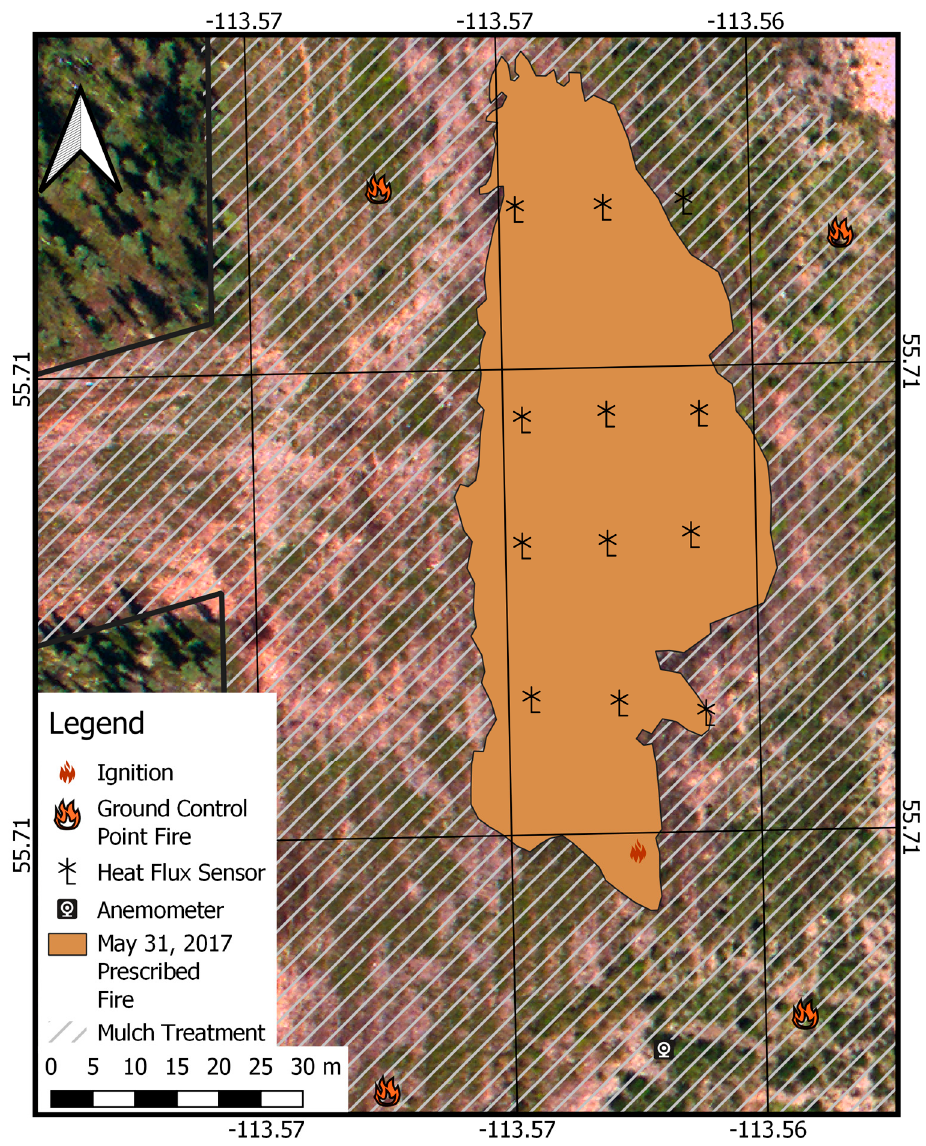
Figure 2. Overview of the experimental design, including heat flux sensor placement, ground control point fires, and the on-site anemometer location.